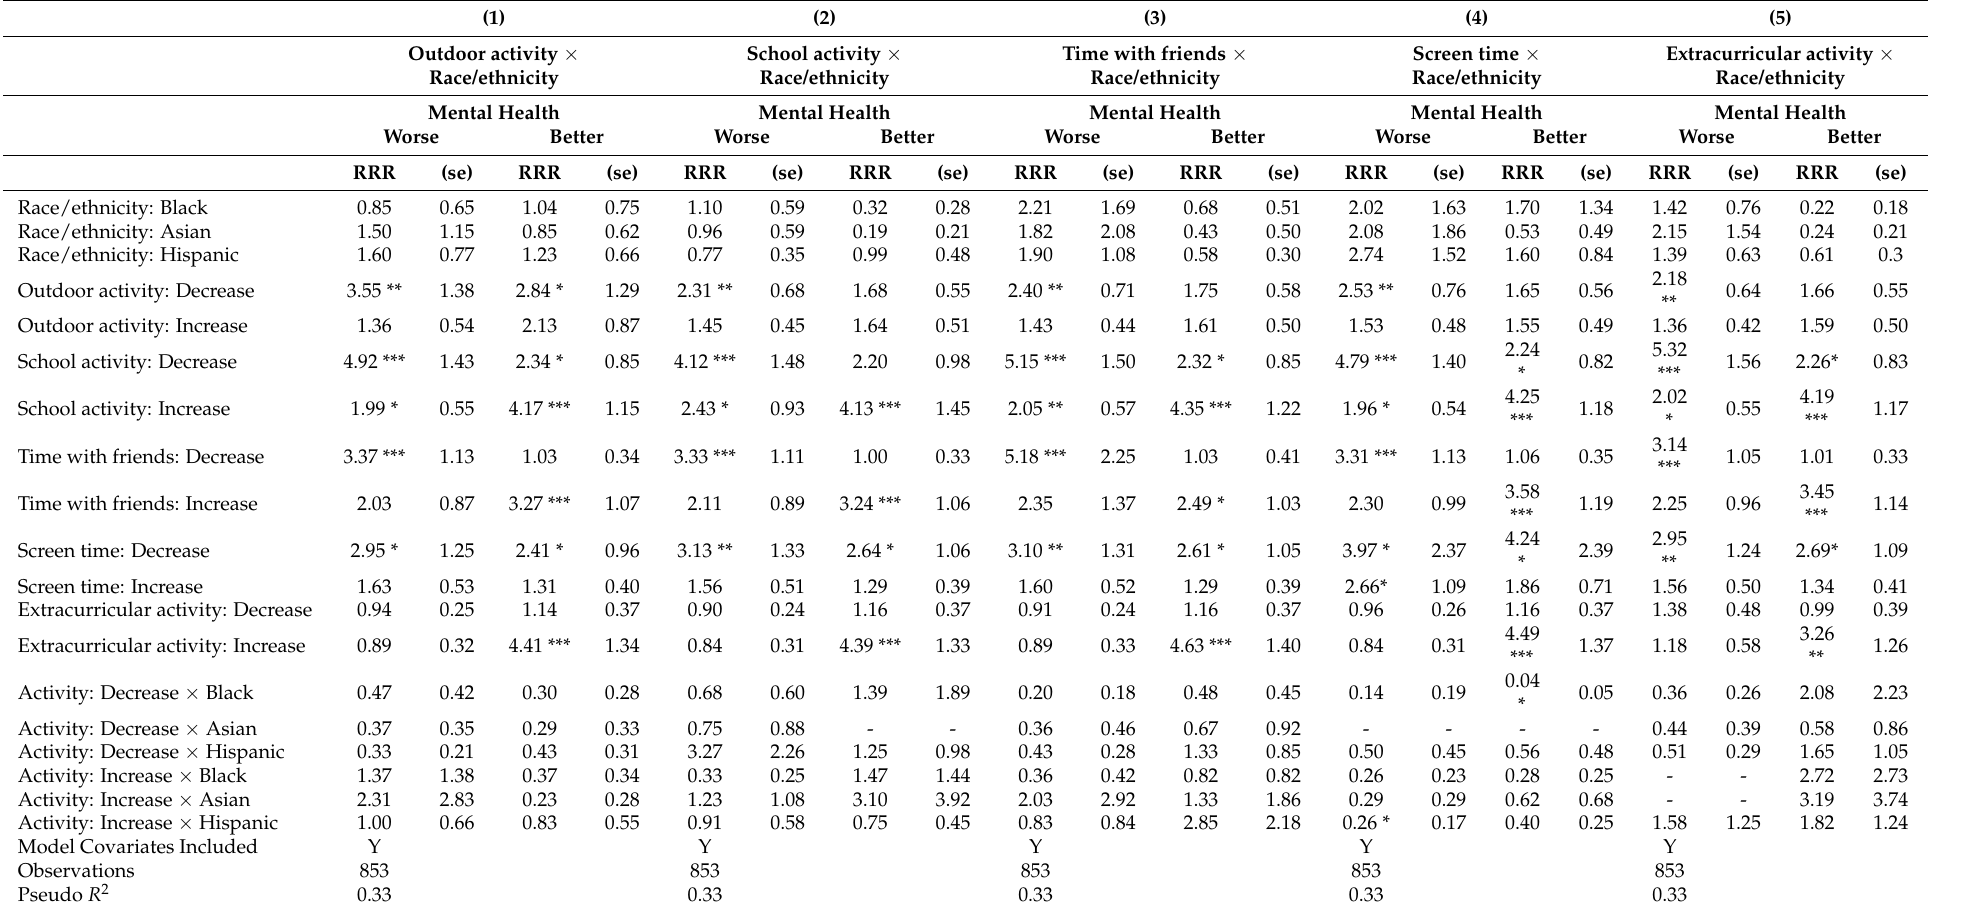
Table 4. Association of changes in child and adolescent activities with changes in mental health during COVID-19 with interactions by race /ethnicity .